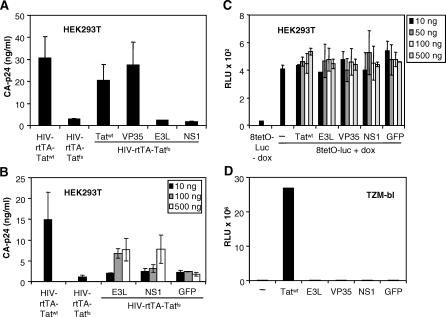
Functional Complementation of the Tat RSS Function by VP35, NS1, and E3L(A and B) HEK293T cells were transfected with HIV-rtTA-Tatwt, HIV-rtTA-Tatfs, and expression plasmids for (A) Tatwt, VP35, E3L, and NS1 (50 ng) or (B) E3L, NS1, and GFP (10, 100, and 500 ng). Virus production was determined 2 d post transfection.(C) To measure transcriptional transactivation capacity of the various proteins, HEK293T cells were transfected with a firefly luciferase reporter under control of the 8tetO promoter (similar to the promoter in the HIV-rtTA constructs), renilla expression vector pRL-CMV, an expression plasmid for rtTA to activate the promoter in the presence of dox, and the indicated amounts of RSSs. Luciferase expression (plotted as firefly/renilla) was determined 2 d post transfection. −, pBluescript (negative control).(D) Transcriptional transactivation capacity of the various RSS proteins was measured using TZM-bl cells that contain a Tat-responsive firefly luciferase reporter gene under control of the HIV-1-LTR. The cells transfected with 0.2 μg of Tat or the indicated RSS expression plasmids. Two to three days after transfection, luciferase expression was measured. −, pBluescript (negative control).